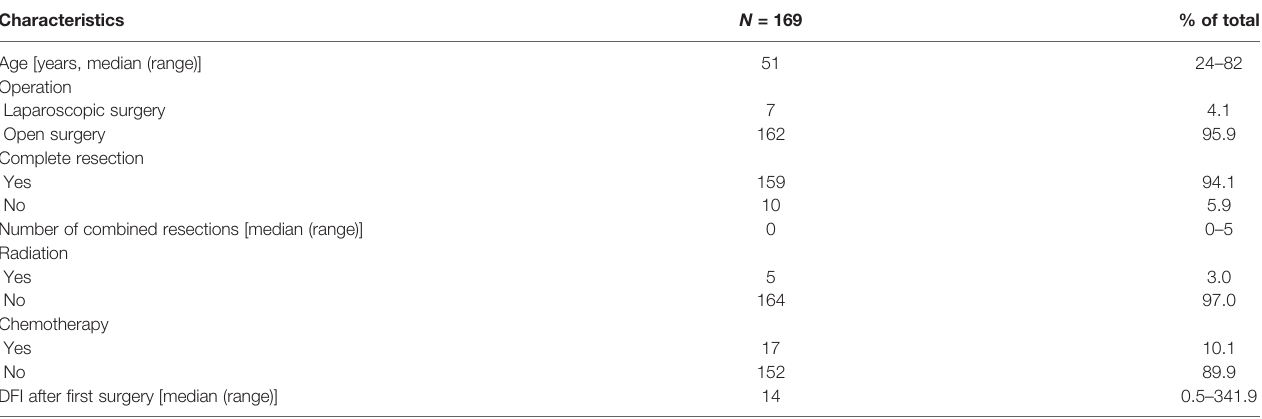
TABLE 1 | Patient and tumor characteristics in 169 patients with primary surgery.